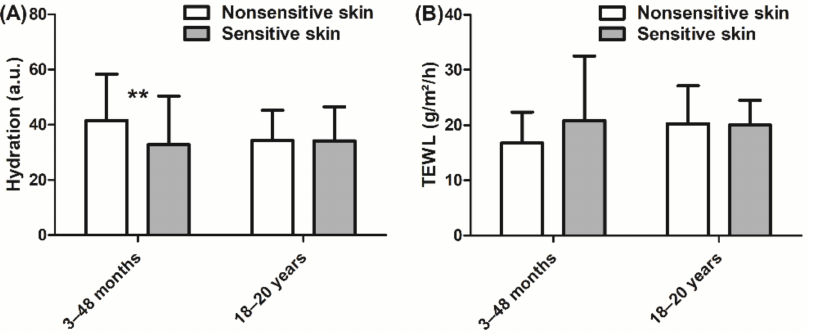
Figure 3. ( A ) Hydration measurement using a Corneometer and ( B ) TEWL (transepidermal water loss) measurement using an Aquaflux. Data are shown as the mean ± SD of all subjects in the group. ** p <